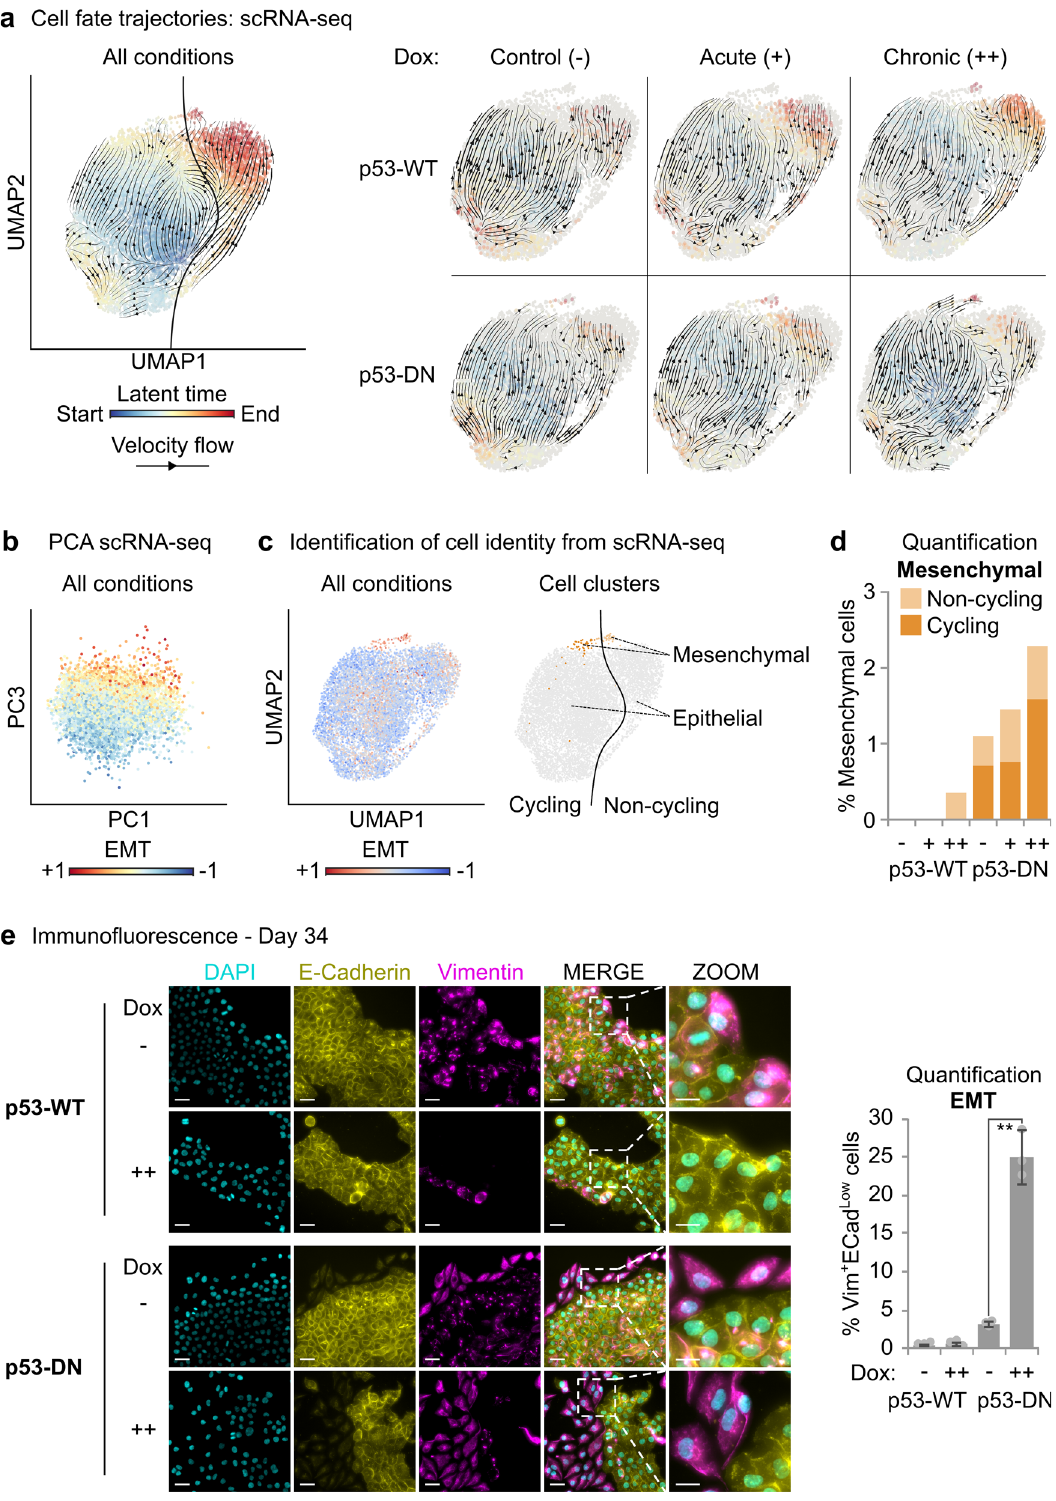
1%; Base media from ThermoFisher Scienti fi c. All cell lines tested and con fi rmed to be mycoplasma free using the Mycoplasma PCR ELISA kit (Sigma). CENP-A overexpression was induced by the addition of Dox to typical growth media at 10 ng/ml (considered 1X), unless otherwise indicated. To maintain overexpression, media and Dox were replaced every 1 – 3 days. When applicable, the media in the non-induced control was replaced in parallel without Dox. For reversal of CENP-A overexpression, we removed media containing Dox and washed two times with warm PBS then replaced the media without